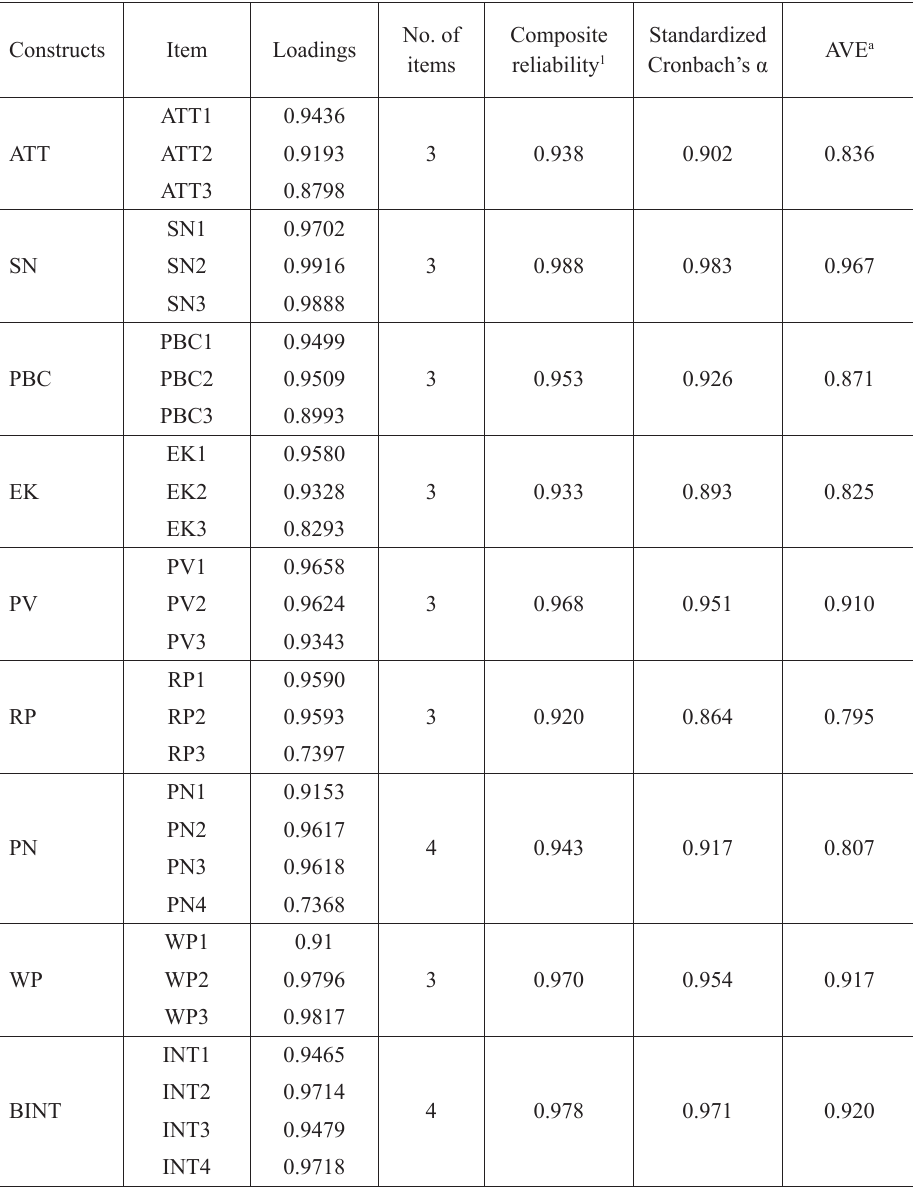
Table 4. The measurement